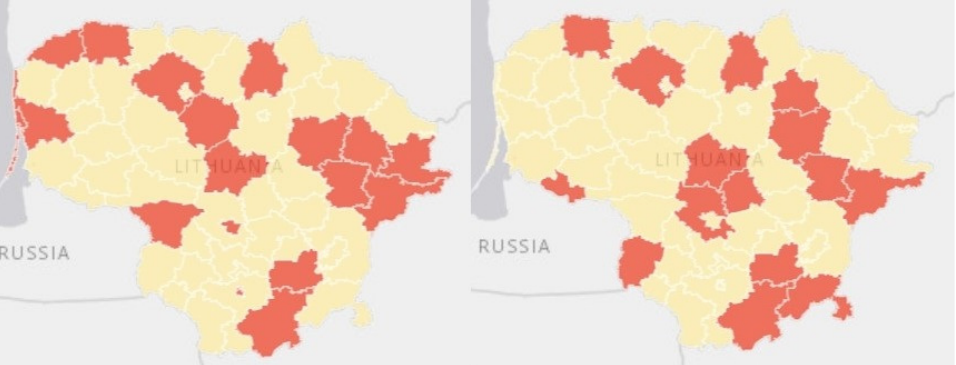
Figure 2. Classified Lithuanian municipalities in 2018 ( left ) and 2019 ( right ). Yellow color areas indicate municipalities with low level of mortality due to ACE (with label value 0) and red areas indicates municipalities with high level of mortality due to ACE (with label value 1).